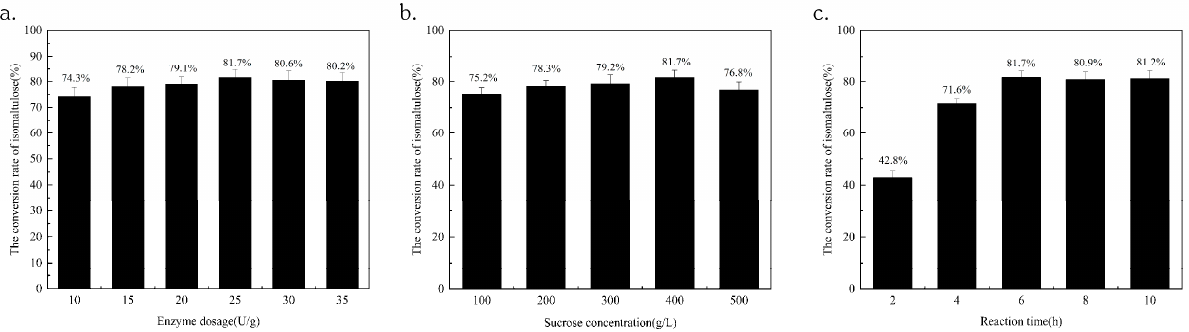
Figure 4. Optimization of isomaltulose production. ( a ) Effect of enzyme dosage on the isomaltulose yield. ( b ) Effect of sucrose concentration on the isomaltulose yield. ( c ) Effect of time on isomaltulose yield.